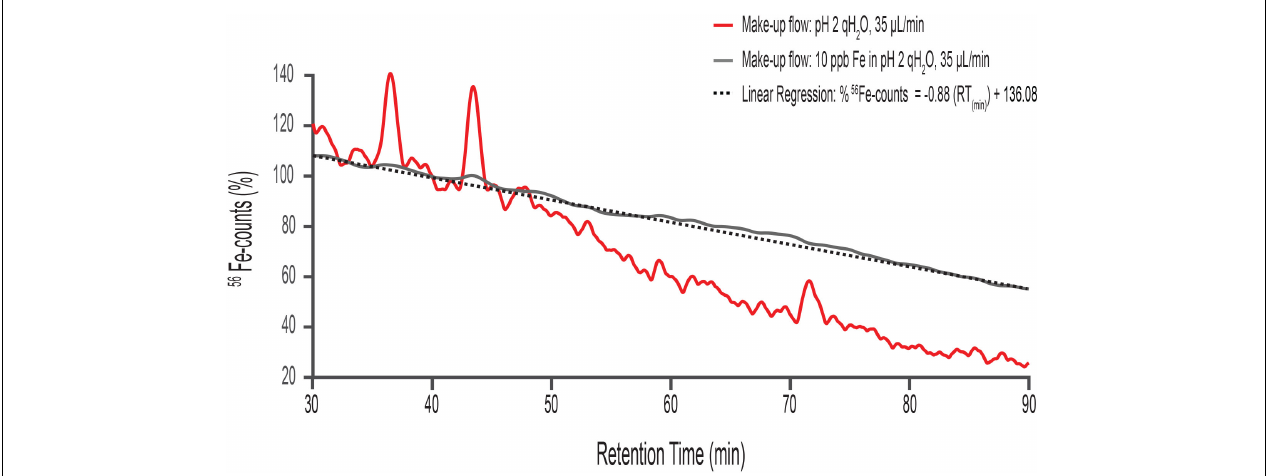
FIGURE 4 | LC-ICPMS 56 Fe-chromatogram of ferrichrome and ferrioxamine E (200 fmol each), with a make-up flow of 35 µ l/min pH 2 qH2O (red trace). To measure the effect of solvent B on the detection of iron, we performed an identical analysis, but added 10 ppb 56 Fe to the make-up flow (gray trace). Iron delivered to the ICPMS in this analysis was dominated by the 10 ppb infusion and was effectively constant over time, making the 56 Fe counts a good proxy of Fe sensitivity by ICPMS. A linear regression of 56 Fe-counts and time (black solid dashed line) gives a good fit to the data with %Fe = –0.88 (retention time (min))+136.08% with r 2 = 0.99. For the comparison here, each 56Fe-chromatogram, was normalized to the 56 Fe counts at 40 min, the average retention time of the two standards.